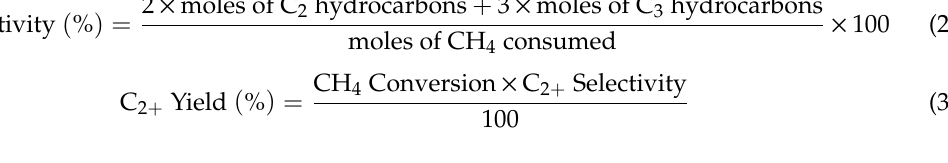
Figure S1: Pore size distribution of supports, such as n-SiC, m-SiC, and SiO 2 . Figure S2: SEM-EDX mapping of (a) MNW / n-SiC, (b) MNW / m-SiC, and (c) MNW / SiO 2 . Figure S3: (a) TEM image and (b) TEM-EDX line concentration profiles for Si, O, Na, W, and Mn along a line drawn across the TEM of MNW / m-SiC. Table S1: Specific surface area, average pore diameter, and pore volume of supported Mn 2 O 3 -Na 2 WO 4